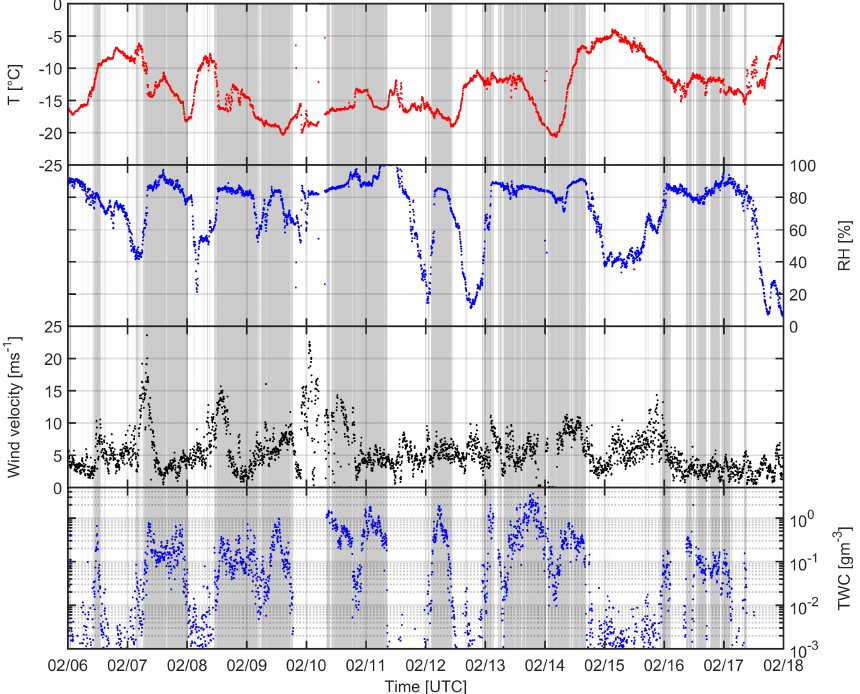
Figure 1. Time series of meteorological data and total water content at the JFJ site for the period 6–18 February. Grey shaded areas denote in cloud periods (TWC ≥ 0.01gm − 3 ).